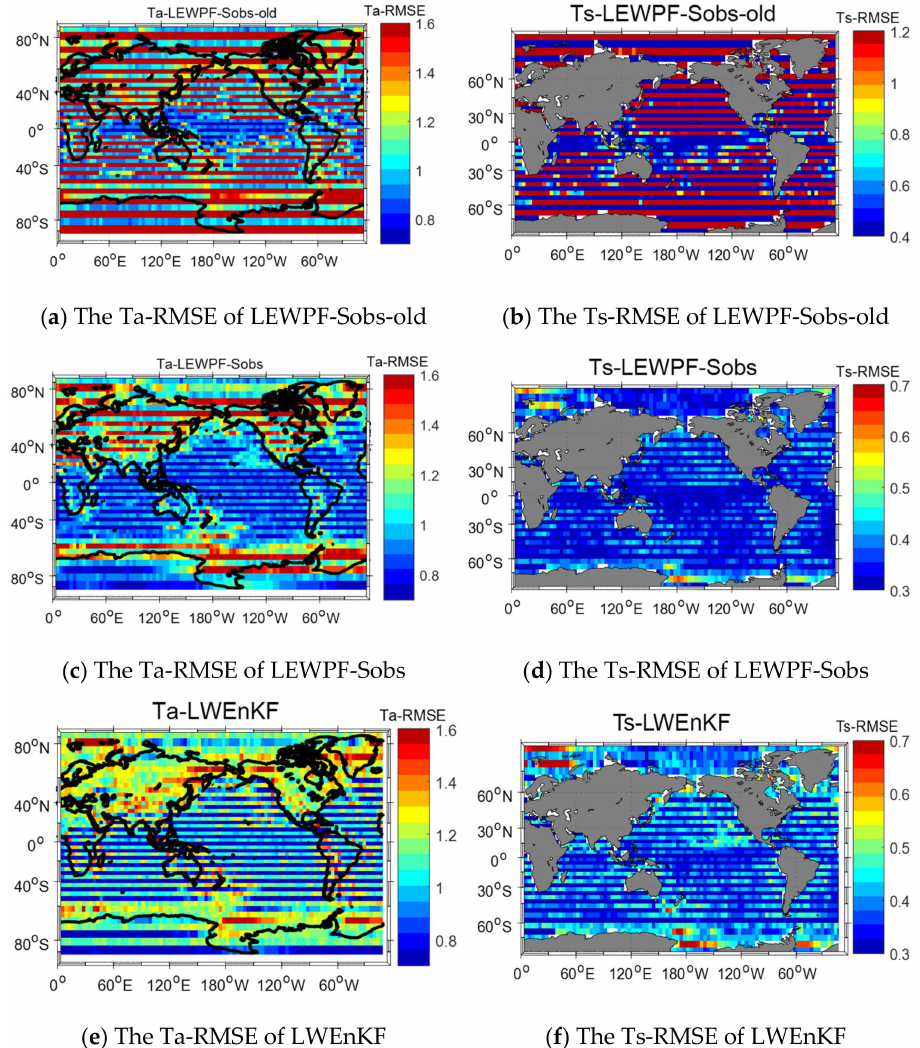
Figure 10. The spatial distribution of annual average RMSE of panel ( a , c , e ) the atmospheric tempera- ture ( T a ) use the spare observations and the RMSE with respect to LEWPF-Sobs-old, LEWPF-Sobs and LWEnKF. The panel ( b , d , f ) are similar to panel ( a , c , e ) but for the ocean temperature ( T s ) use the sparse